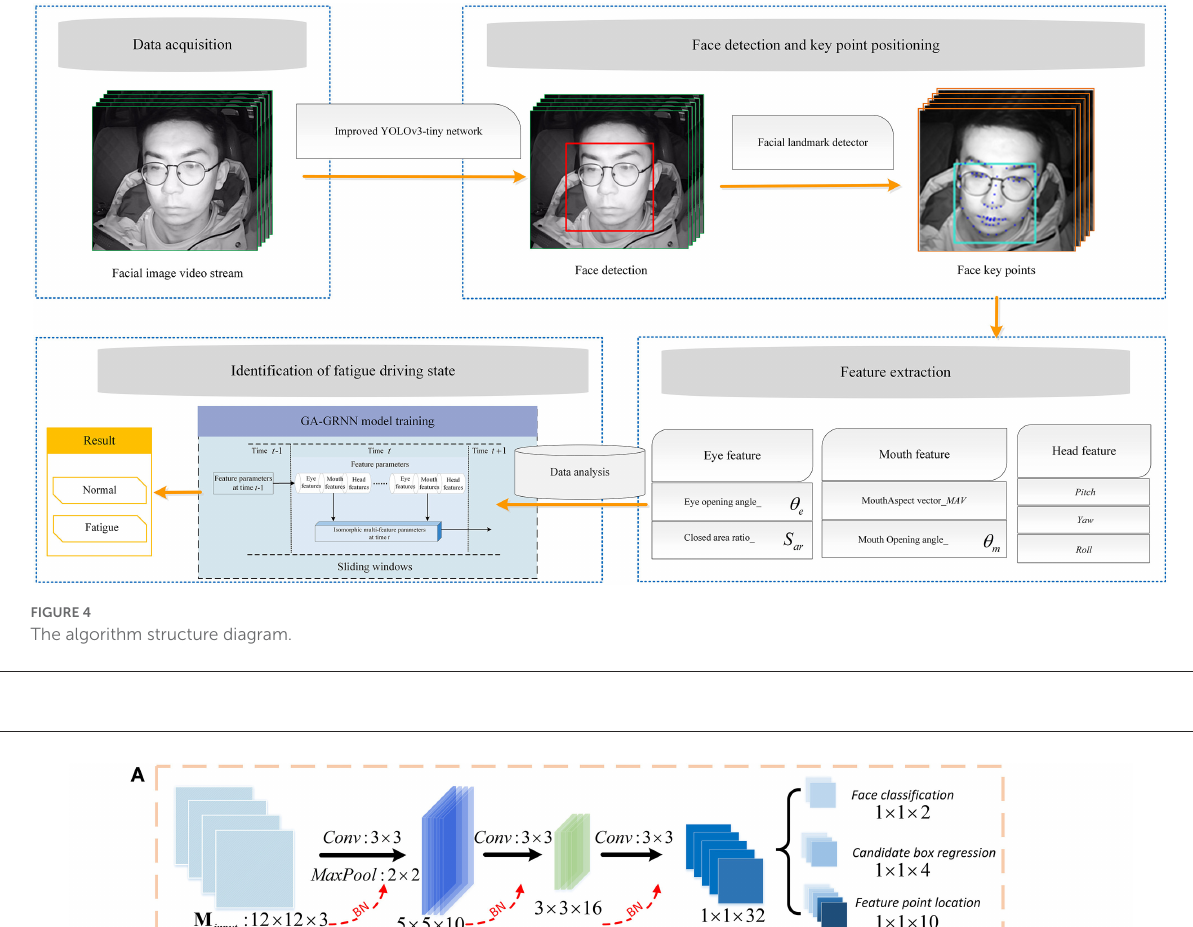
FIGURE4 The algorithm structure diagram.